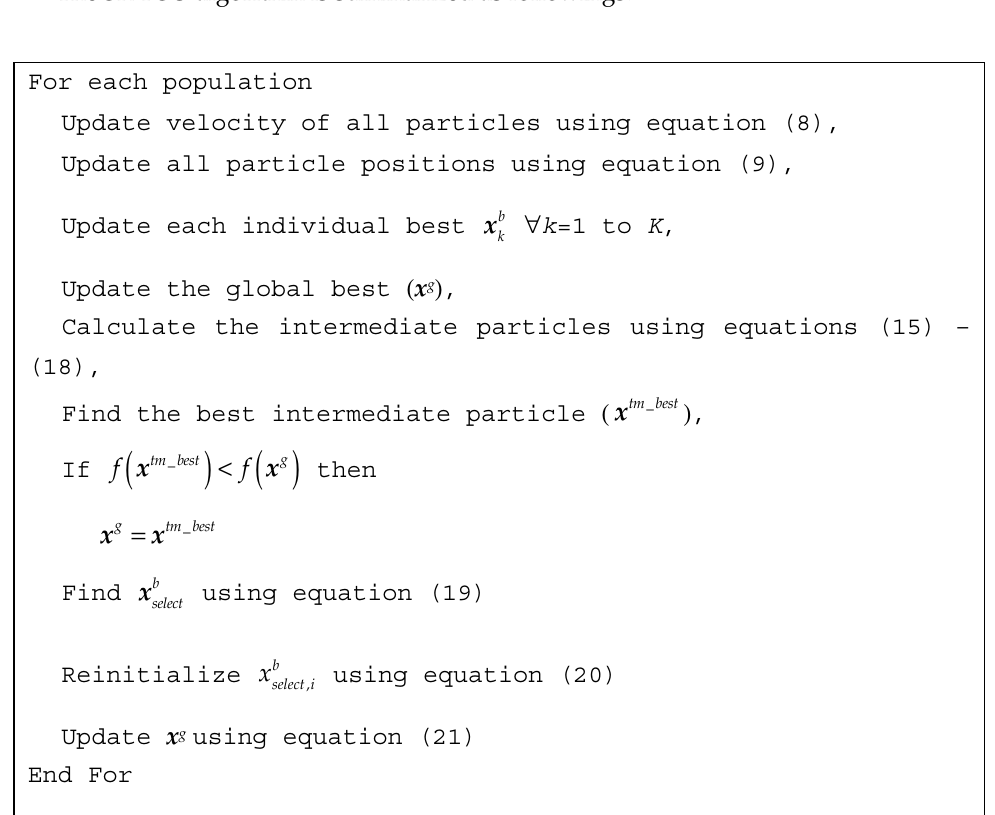
Figure 10. The best SR-PSO with the ICP registration results for the pairs ( a ) 1 and 2; ( b ) 2 and 3; ( c ) 3 and 4; ( d ) 4 and 5; ( e ) 5 and 6 of the regular-tooth model. Table 7. MSE of the final registration of six consecutive views (micrometer 2 ) for the regular-tooth model (the best value is in